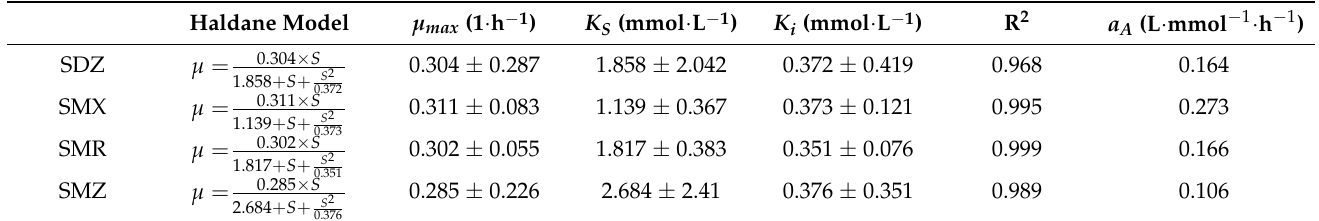
Table 2. Kinetic parameters for strain YL1 growth on SAs used in the Haldane model.